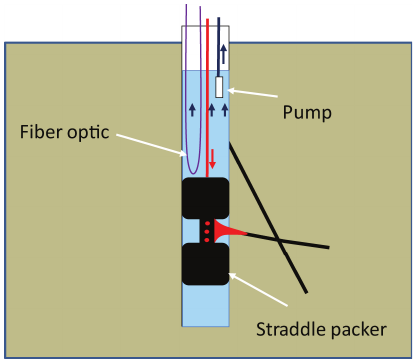
Figure 2. Experimental set up of the single-well thermal tracer